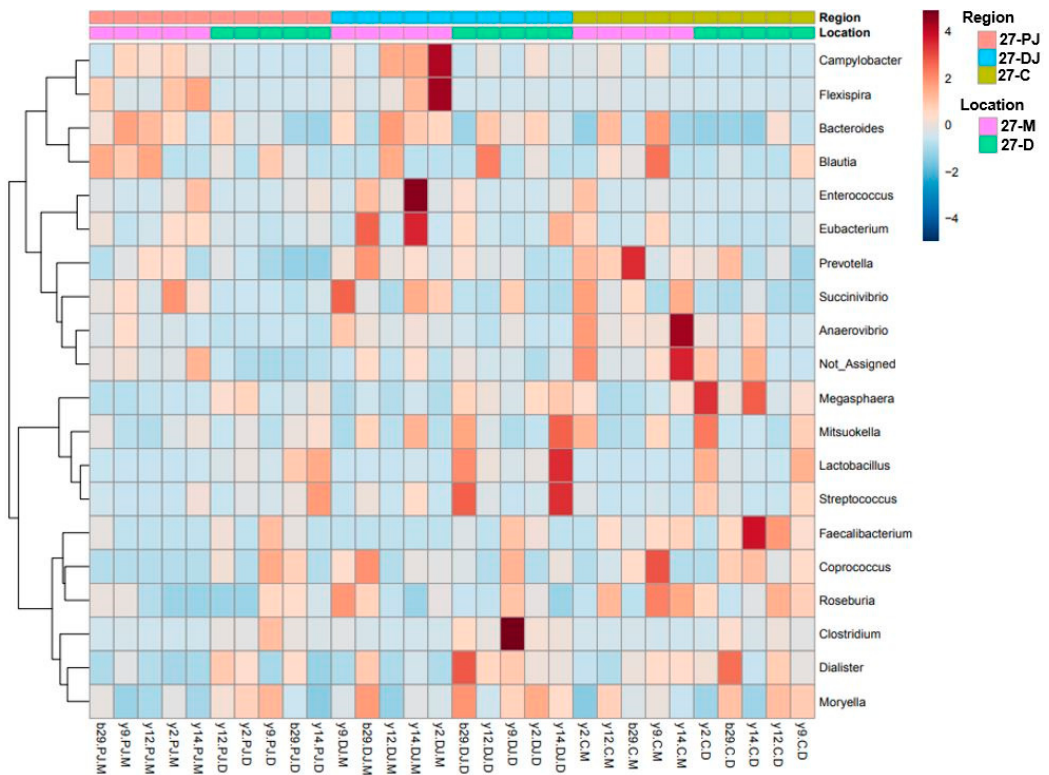
Figure 4. Hierarchical clustering heat map of bacterial genera from 27-day post-weaned pigs generated by MicrobiomeAnalyst using Euclidean distance measure and Ward clustering algorithm. The 27 represent 27 days post weaning; M and D represent mucosa and digesta samples, respectively; PJ, DJ, and C represent proximate jejunum, distal jejunum, and mid-colon, respectively. Not_Assigned represents the sequence reads that were not assigned at the genus level but assigned at the higher taxonomic level.